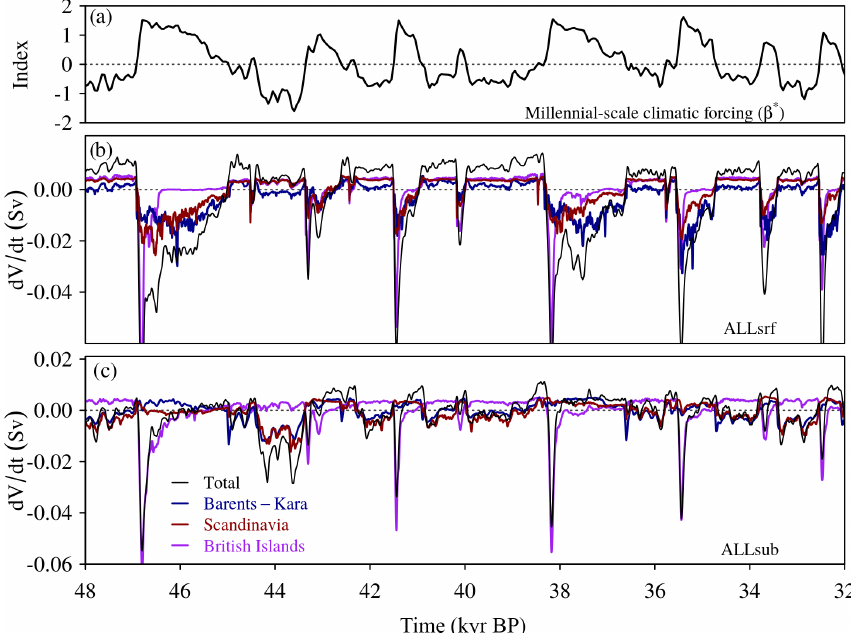
Figure 8. MIS 3 period. (a) Temporal component of the millennial-scale climatic forcing ( β (cid:63) index), and the contribution of the different regions to ice volume variations (Sv) in the simulations considering all forcings, with (b) corresponding to the surface oceanic forcing (ALL srf ) and (c) to the subsurface oceanic forcing (ALL sub ). The geographical domains of the different regions are highlighted in Fig.